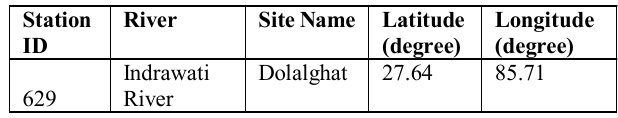
Table 2. Hydrological Station in project site